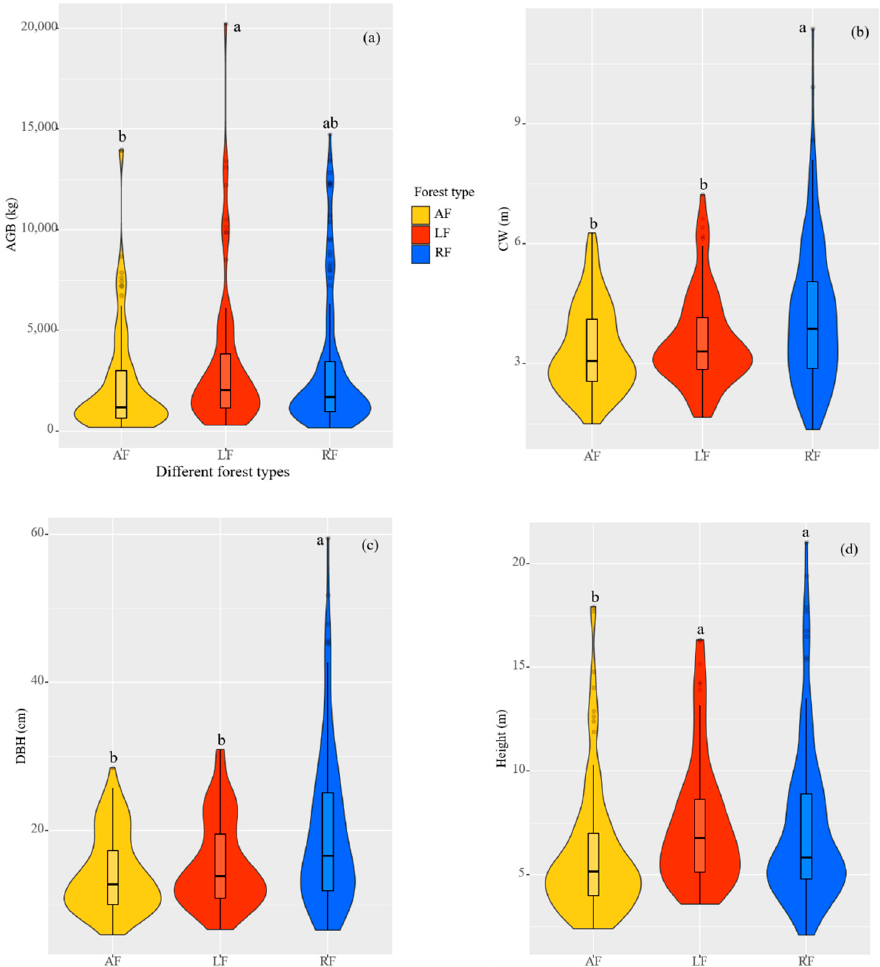
Figure 2. The distribution of AGB and structural and diversity attributes. ( a ) depicts the distribution of above-ground biomass (AGB); ( b ) depicts the distribution of crown width (CW); ( c ) depicts the distribution of diameter at breast height (DBH); ( d ) depicts the distribution of tree height. In the figure, the horizontal black line in the middle is the median, the box shape ranges from the lower quartile to the upper quartile and the thin black line represents the whiskers. The outer shape is the kernel density estimate (used to estimate unknown density functions in probability theory, one of the nonparametric test methods). In the figure, mean values sharing different letters are significantly different ( p < 0.05), and mean values sharing the same letters are not significantly different ( p > 0.05). RF, road forest; AF, attached forest; LF, landscape and relaxation forest.